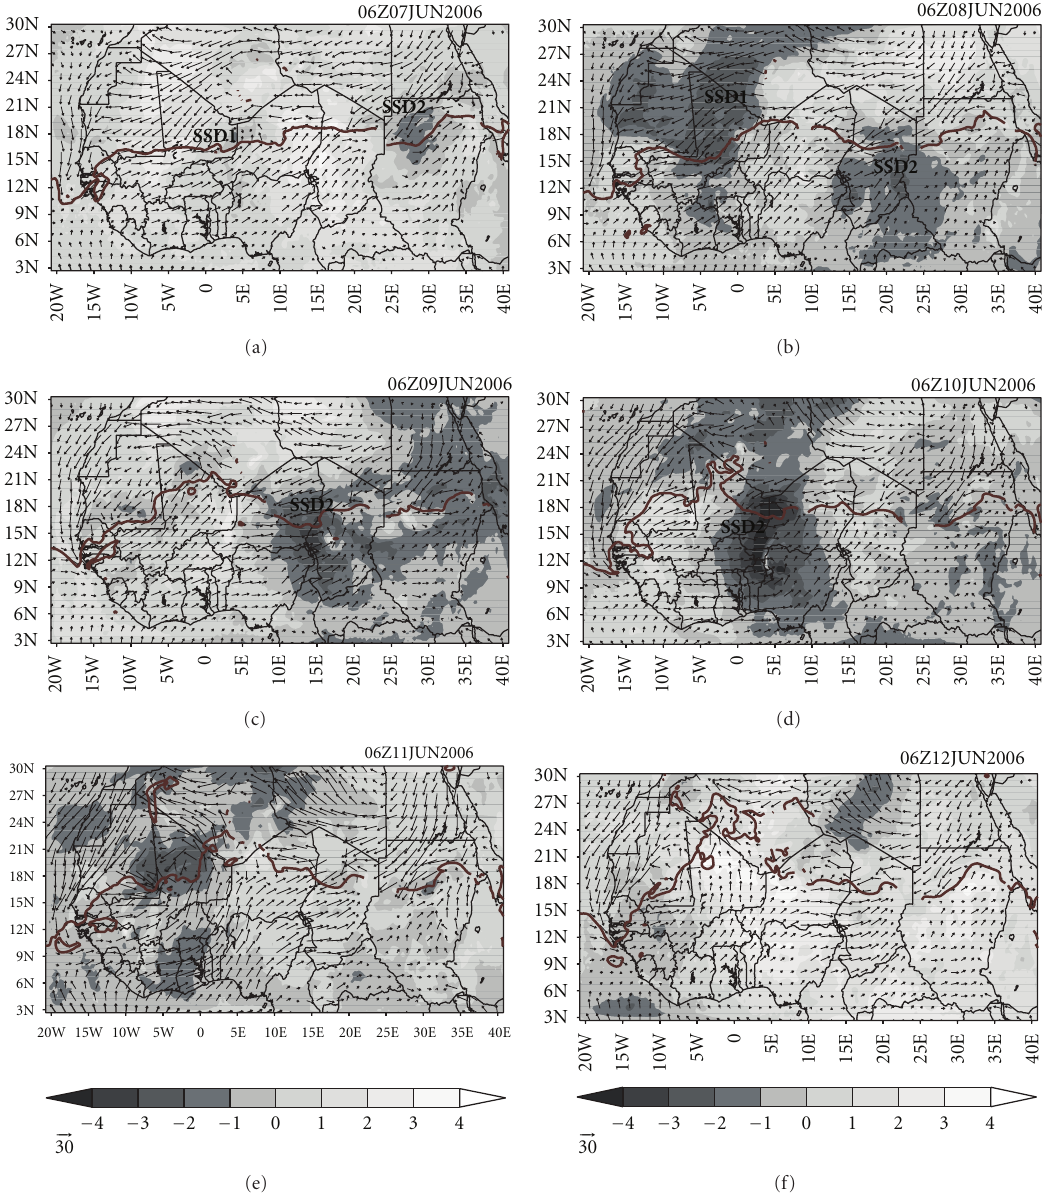
Figure 2: Synoptic weather conditions during the study period. WRF-Chem EXP30-simulated sea level pressure (shaded) at 0600 UTC with the diurnal cycle removed, winds at 925 hPa (vectors), brown line indicates the 12 grkg water vapor isopleth (approximate ITD location). (a) 7th, (b) 8th, (c) 9th, (d) 10th, (e) 11th, and (f) 12th of June, 2006.